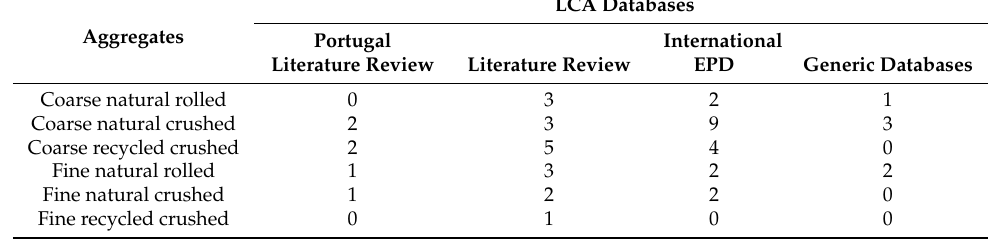
Table 2. Datasets for the production of coarse and fine, natural and recycled, rolled and crushed aggregates.